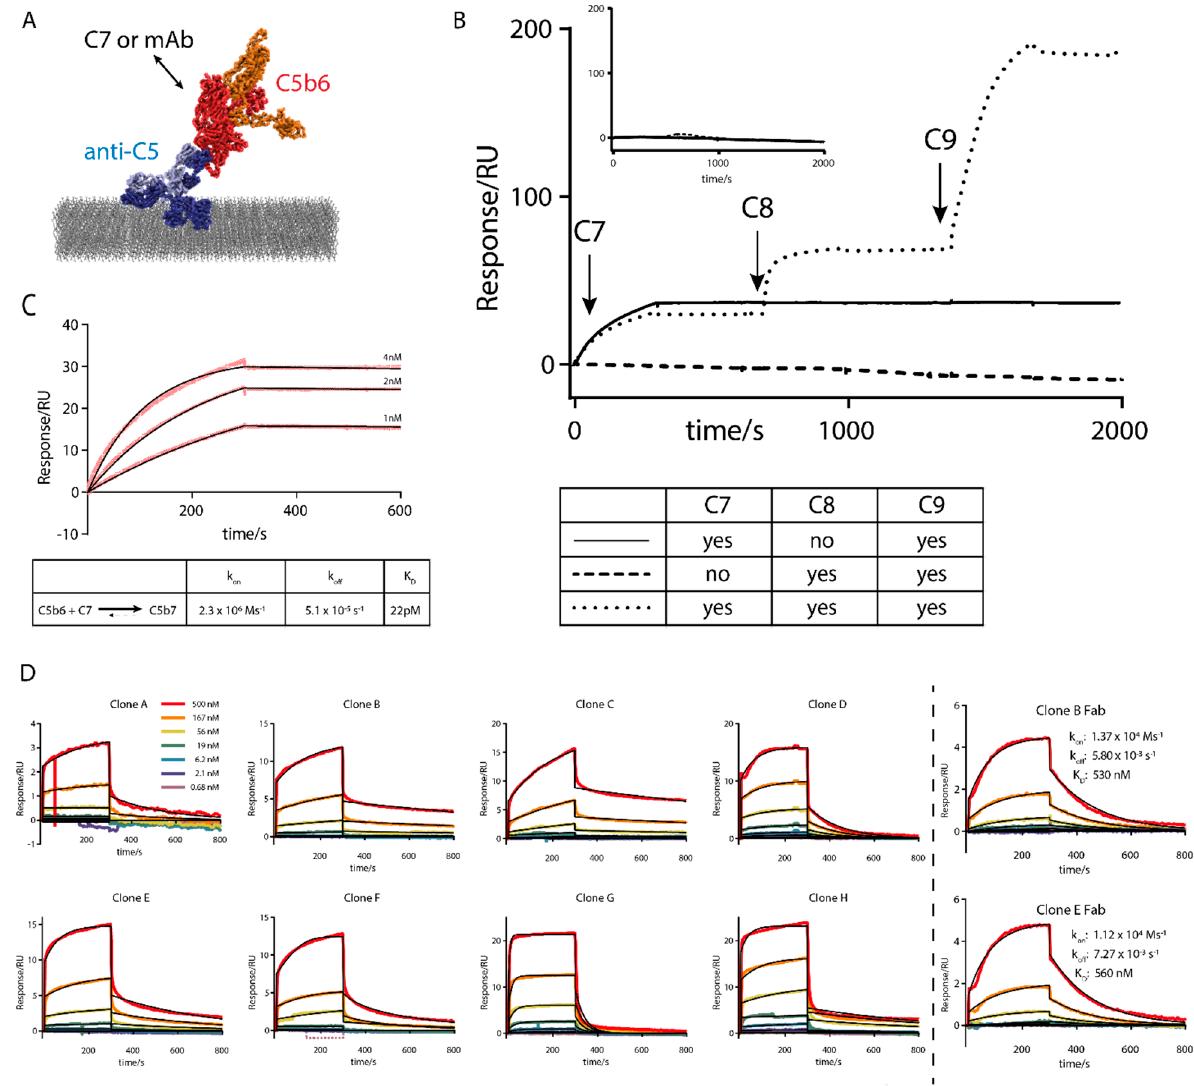
Figure 4. MAC on a chip and a novel SPR assay format. ( A ) Schematic representation of the SPR assay format. Composite model generated using PDB depositions 5I5K and 4A5W. An anti-C5 tool antibody (blue) is immobilised on a CM5 chip (grey) and C5b6 (red/orange) is captured by the antibody. Analytes can then be tested for binding against C5b6. ( B ) Reconstitution of the membrane attack complex on an SPR chip surface. Analytes injected as indicated by the legend. Experiment was performed with either captured C5 (inset) or C5b6 (main). ( C ) Measuring the on − rate of C7 on C5b6. Experimental data in red and fit to a 1:1 binding model in black. Table of kinetic parameters below. ( D ) Binding of the 8 hit panel clones to anti-C5 captured C5b6. Experimental data coloured as indicated in the legend. Fits to a 1:1 binding model in black. Excluded data shown as dotted lines. Binding kinetics only reported for the true 1:1 Fab-binding.